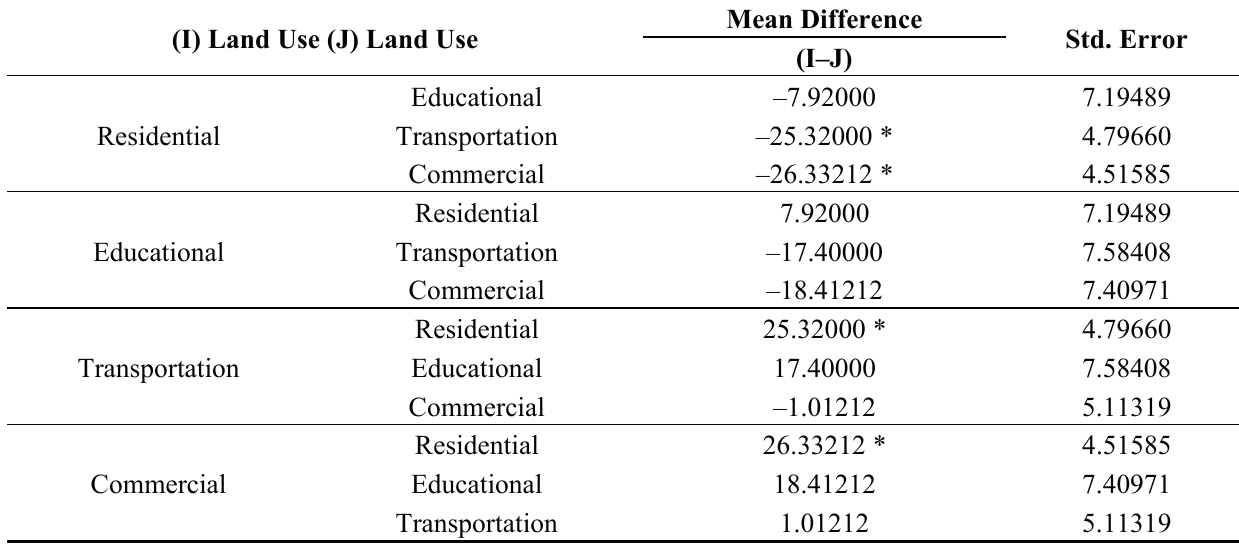
Table 7. Tukey’s HBD Multiple comparison between noise levels across land use types Dependent Variable: Noise, Tukey